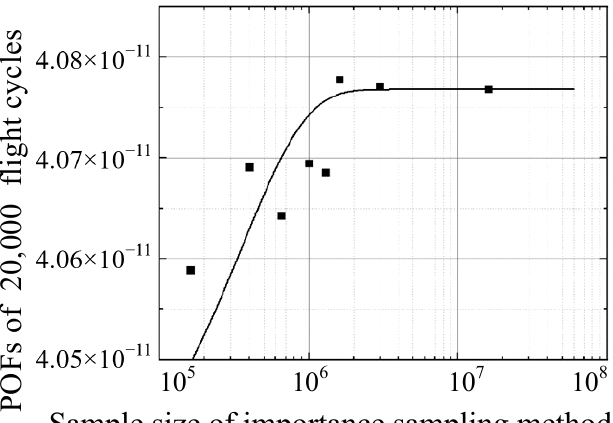
Figure 14. POFs of cases applying importance sampling method.